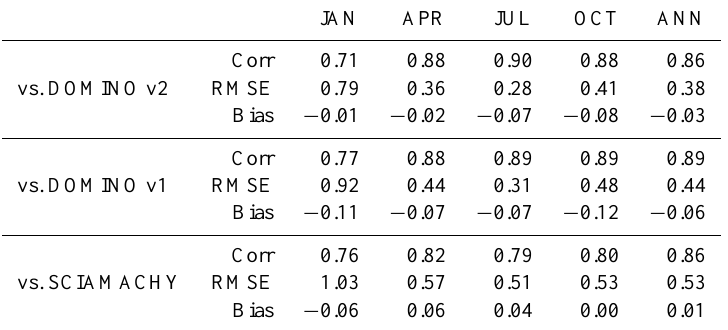
Table 1. Comparisons of monthly and annual mean tropospheric NO 2 columns between the CHASER simulation (applying the AK of each retrieval) and the satellite retrievals: DOMINO v1, DOMINO v2, and SCIAMACHY, for 2005. The RMSE is the root-mean-square error. The bias represents the CHASER simulation minus the retrievals. The units for the RMSE and bias are 10 15 molec . cm − 2 .